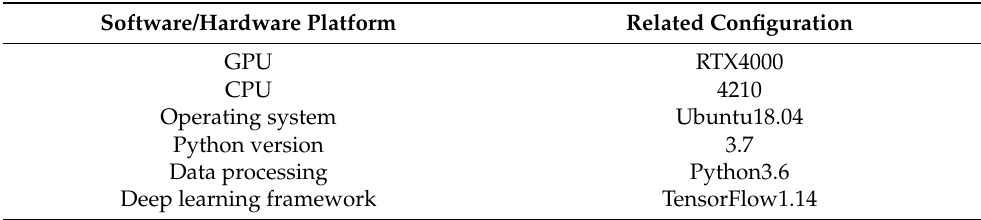
Table 1. Parameters of the test